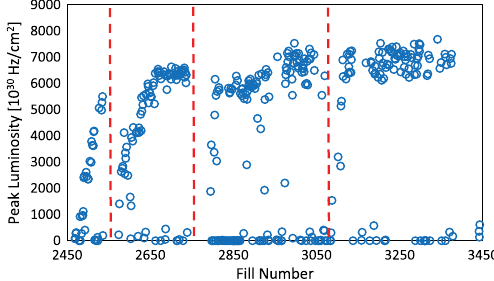
FIG. 3. Peak luminosities of fills during 2012. The lines indicate the technical stops [3].